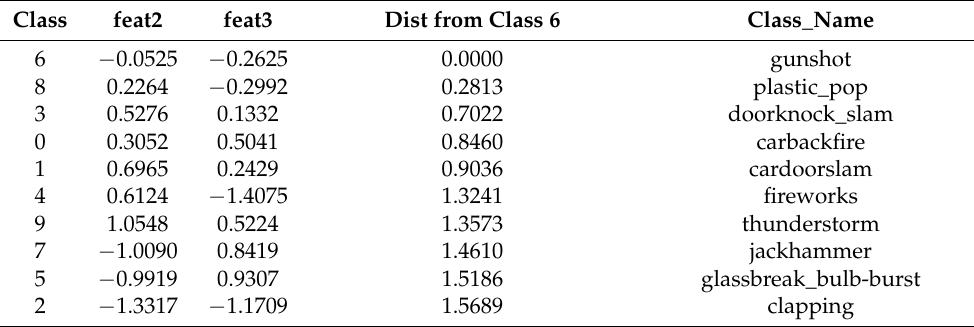
Figure 9. ( a ) 2D scatter plot of feature 2 vs feature 3 with centroids and ( b ) 3D plot of features 2, 3, and 40. Table 4. Comparison of relative distances from the gunshot sound to the gunshot-like sounds.